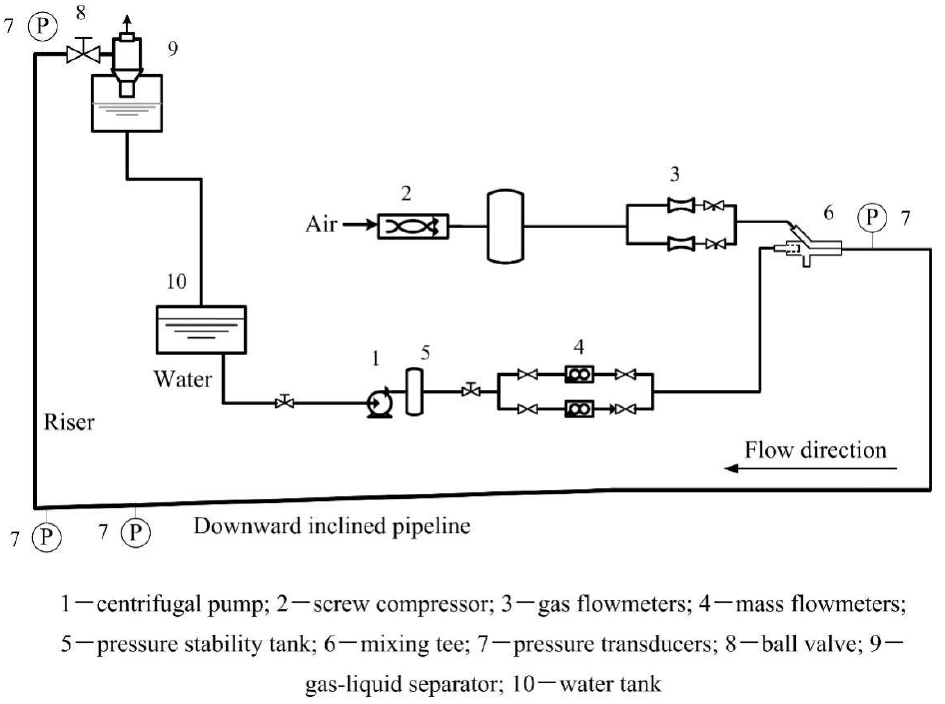
Figure 1. Schematic diagram of the air and water two-phase experimental test